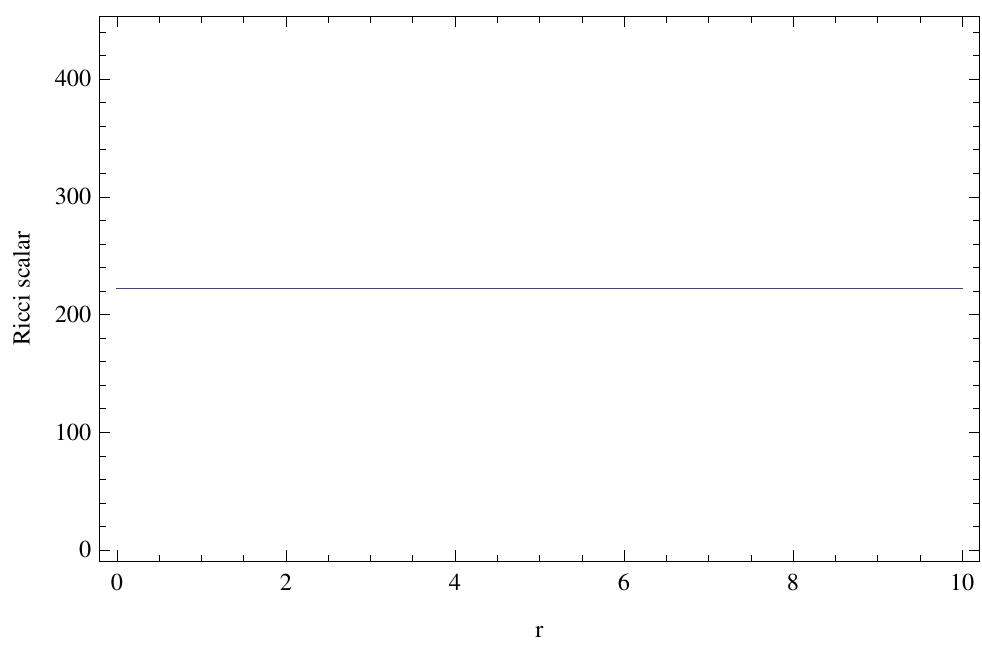
The radial profile of the Ricci scalar for λ = 0.1 is plotted in Figures 7 and 8 below. The Ricci scalar is observed to be positive and constant in Figure 7 (dark energy matter), whereas it is positive and increasing in Figure 8 (quintessence matter).